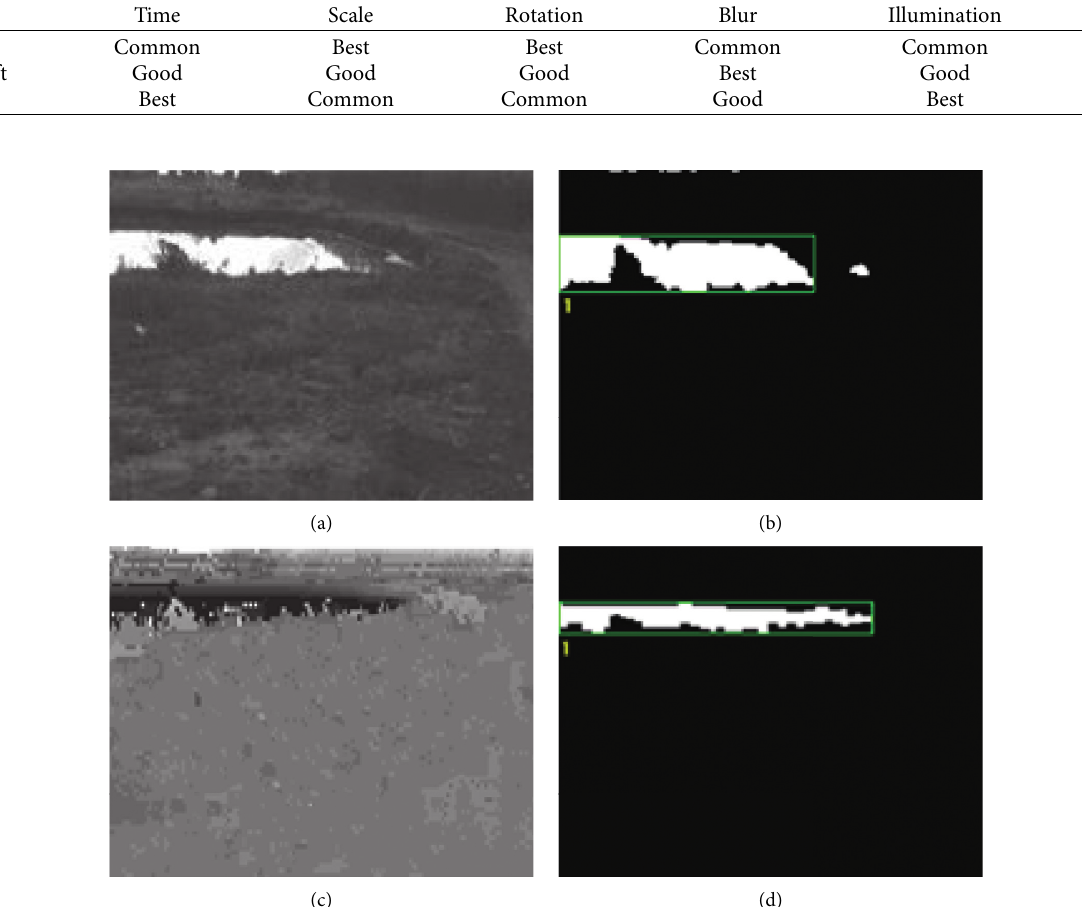
Figure 19: Preliminary front water recognition for off-road intelligent vehicle. (a) CCD image. (b) Water detection based on CCD image. (c) Laser image. (d) Water detection based on laser image.